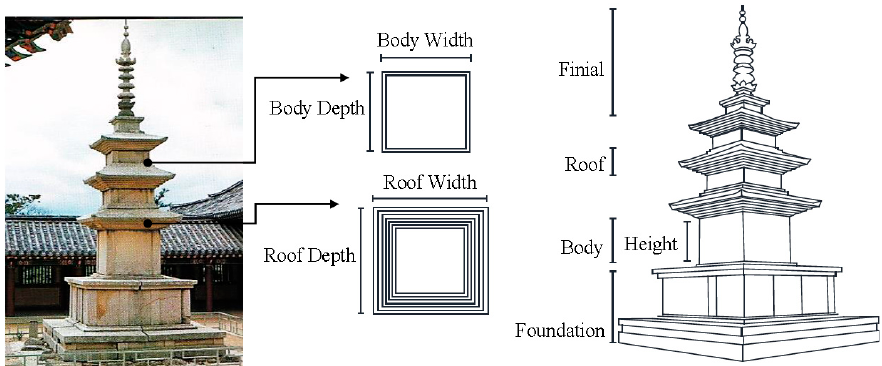
Figure 3. The composition and term definitions of the pagoda, in the example of the S ŏ kkat’ap Pagoda at the Pulguksa Buddhist Temple (Ky ŏ ngsik Pak 2008; the authors newly re-modify the figure in the paper by Yavartanoo and Kang 2017).